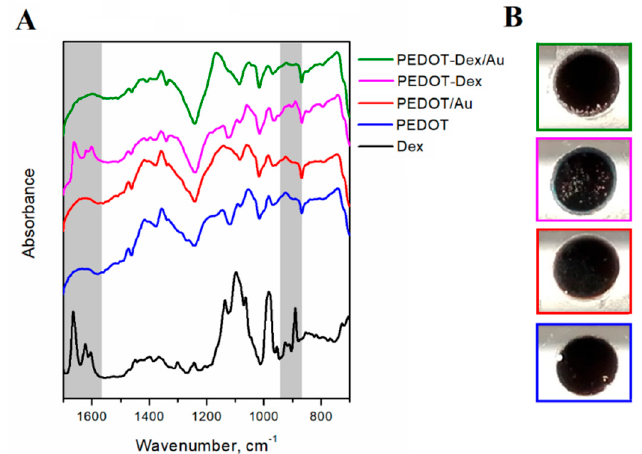
Figure 2. Surface characteristics of PEDOT functionalized Pt electrodes. ( A ) Fourier transform ‐ infrared (FTIR) spectra and ( B ) macroscopic images of Dex, pristine PEDOT, PEDOT/Au, PEDOT ‐ Dex and PEDOT ‐ Dex/Au; grey regions in FTIR spectra indicate signals characteristic for Dex that can be found in PEDOT ‐ Dex and PEDOT ‐ Dex/Au.